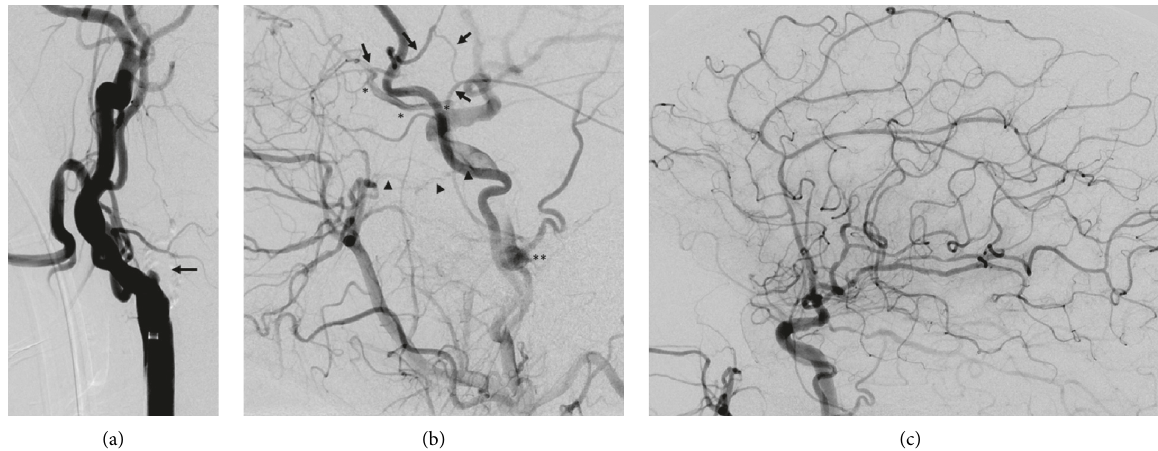
Figure 2: (a) Lateral angiogram of the common carotid artery (CCA) showing occlusion of the ICA. (b) Lateral CCA angiogram: exclusive filling of the intracranial vessels through multiple collaterals ( ∗ ), retrogradely filled ophthalmic artery (OA); arrows depict a connection between the middle meningeal artery (MMA) and OA. Dural anastomoses from MMA to ICA at the level of the skull base ( ∗∗ ); arrow heads depict a branch of the sphenopalatine artery feeding the cavernous ICA (superimposed by the superficial temporal artery). (c) Lateral angiogram after intervention: (TICI3). Vessel wall irregularities are rated as